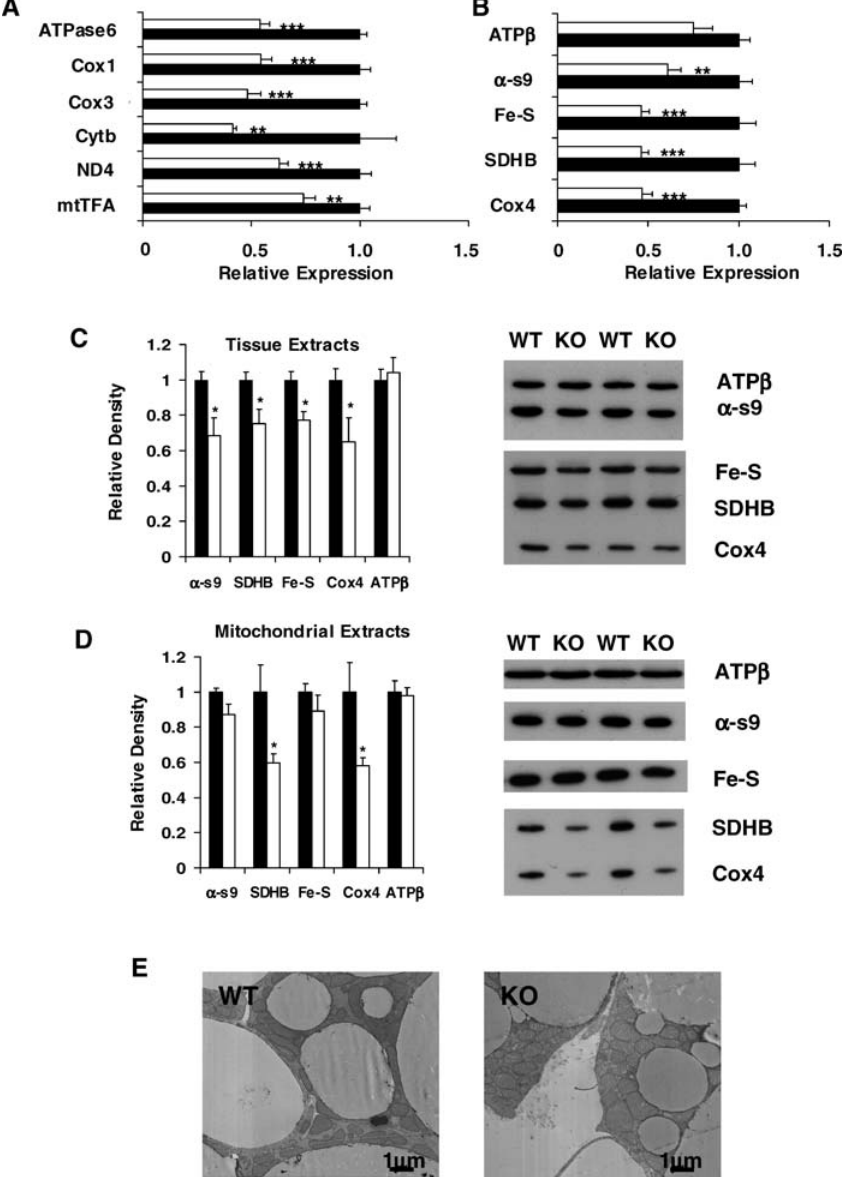
Figure 4. PGC-1 b Ablation Reduces ETC Gene and Protein Expression but Mitochondrial Volume Fraction is Unaffected (A and B) Expression levels of (A) nuclear-encoded and (B) mitochondrially encoded genes were assessed on interscapular BAT from 12-wk-old male WT (black bars) and PGC1 b KO (white bars) mice. Individual measurements are standardized using 18S, and the average of the WT group set to 1. n ¼ 5–7 mice per group. (C and D) BAT protein levels of ETC and OxPhos components from 15-wk-old female mice were assessed by western blotting of samples from (C) tissues and (D) mitochondrial fractions. WT, black bars and PGC1 b KO, white bars. Complex I, a -subcomplex 9 ( a -s9); complex II, succinate dehydrogenase subunit B (SDHB); complex III, Fe-S core protein (Fe-S); complex IV, Cox4; complex V, ATP synthase subunit b (ATP b ). n ¼ 5–6 mice for each protein, with the average value of the WT group set to 1. Representative blots showing two samples from each genotype. (E) Representative electron micrographs from BAT of WT (left panel) and PGC1 b KO (right panel) mice. DOI: 10.1371/journal.pbio.0040369.g004